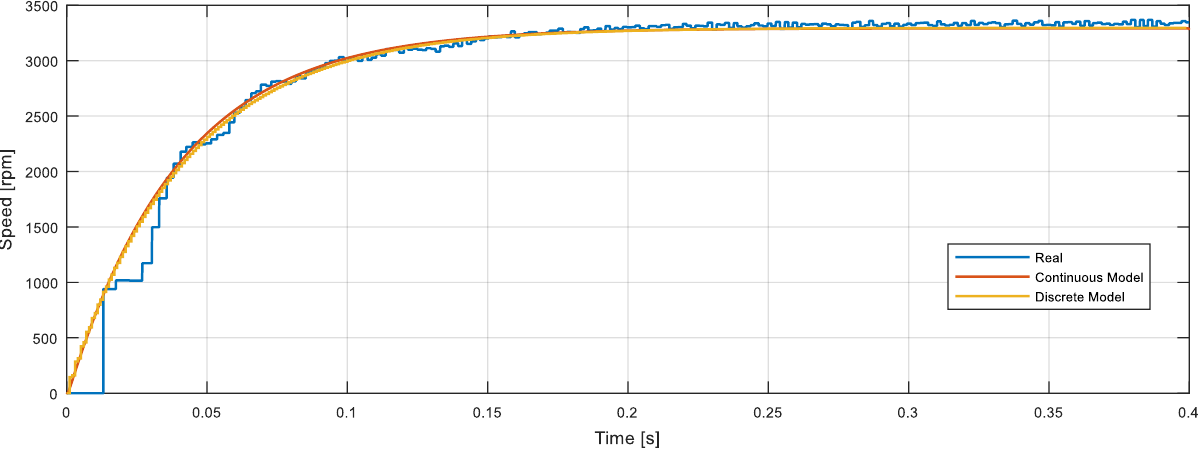
Figure 14. Open-loop motor step response comparison: real motor speed gathered from the encoder (blue line), continuous-time (red line) model simulation, and discrete-time (brown line) model simulation.